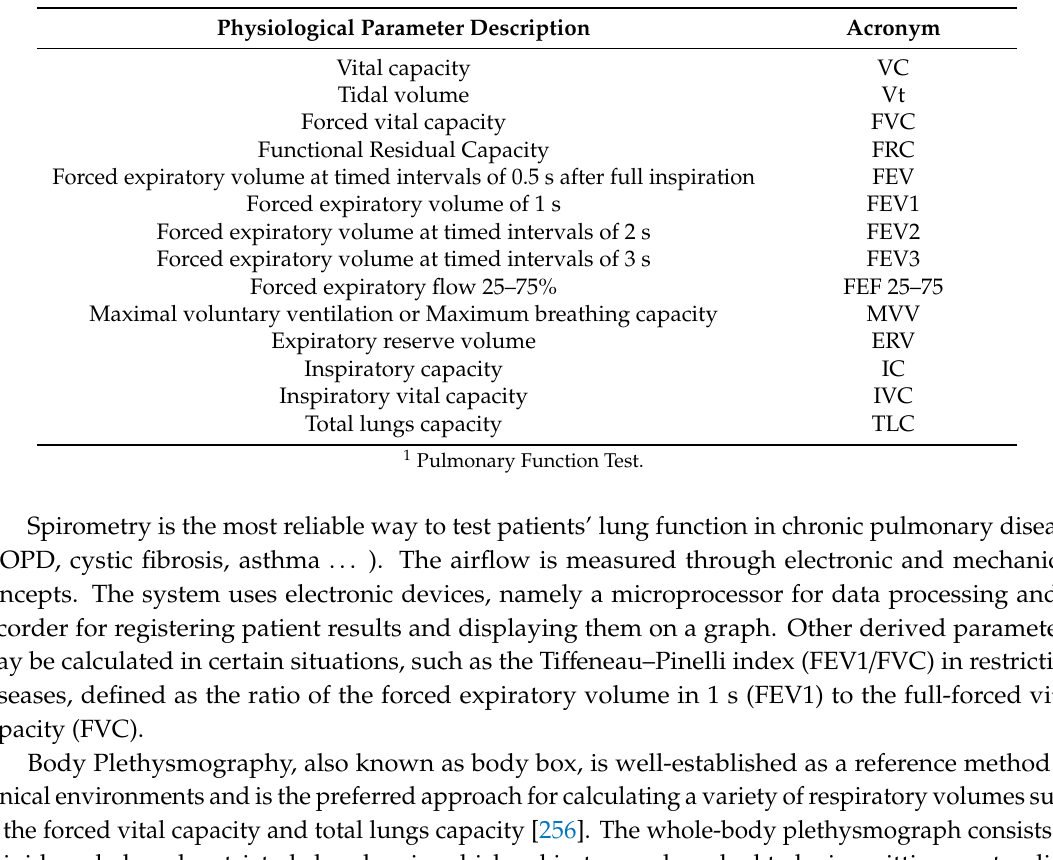
Table A1. A summary of the common parameters considered in spirometry and PFT 1